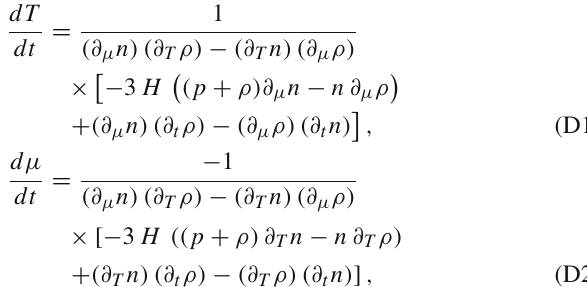
value, a very conservative constraint within our cosmology would be (cid:2) N BBN